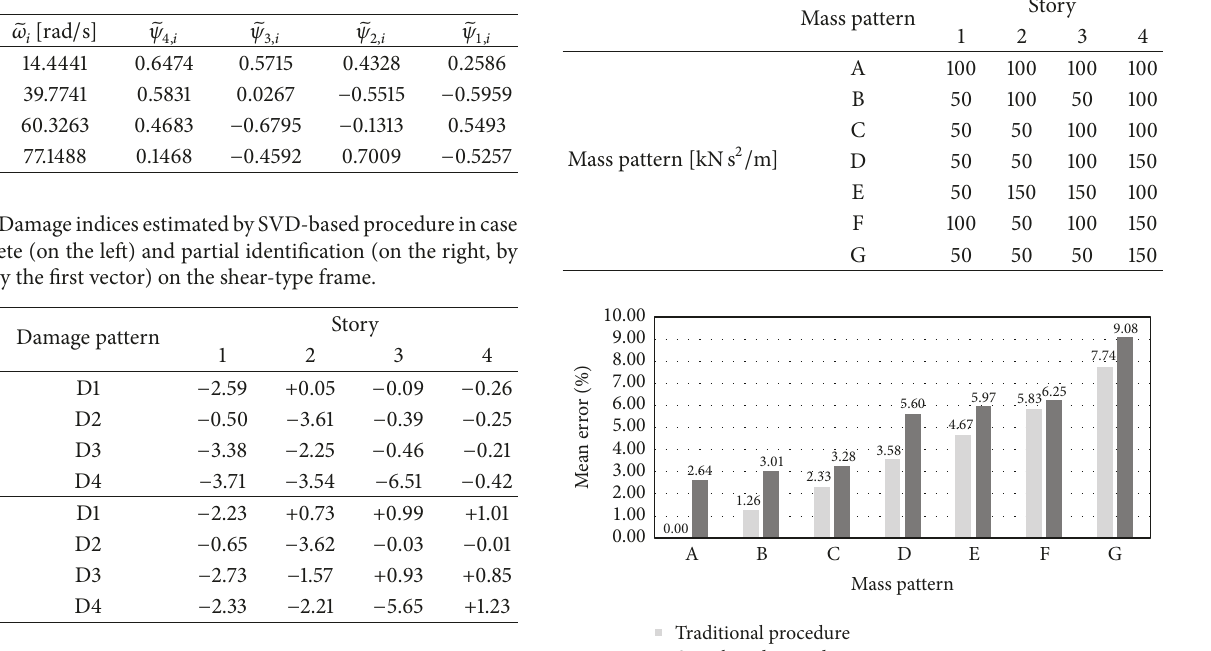
Table 8: Modal parameters identified for the damaged frame, according to the pattern D1 of Table 7. Natural frequencies are identified by the RWS-TSVD-based algorithm.